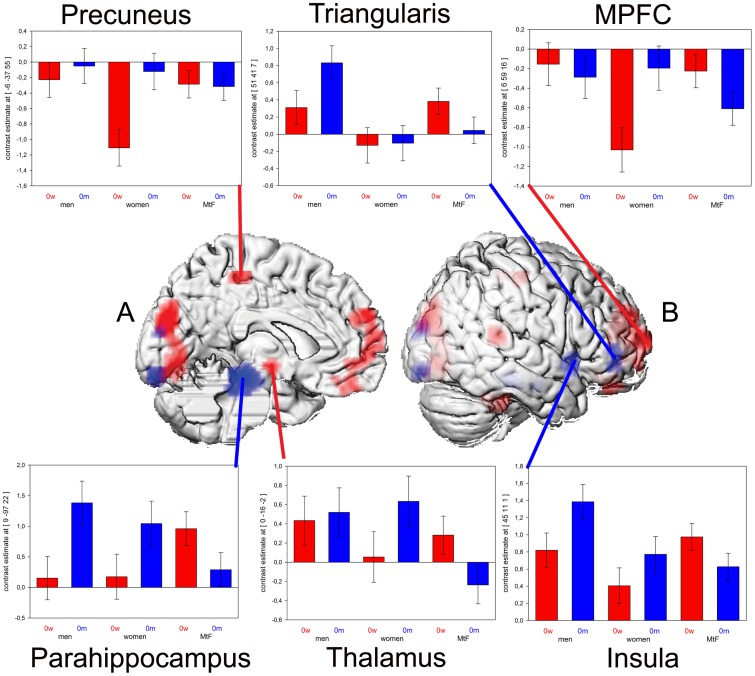
Interaction between original voice sex and group (p<0.05 Monte Carlo corrected, extent threshold  = 20 voxels).Male vs. female voices in men compared to MtFs (blue) and in women compared to MtFs (red).Parameter estimates are shown separately for male (0 m) and female (0 w) voices for men, women and MtFs A: left hemisphere, B: right hemisphere.